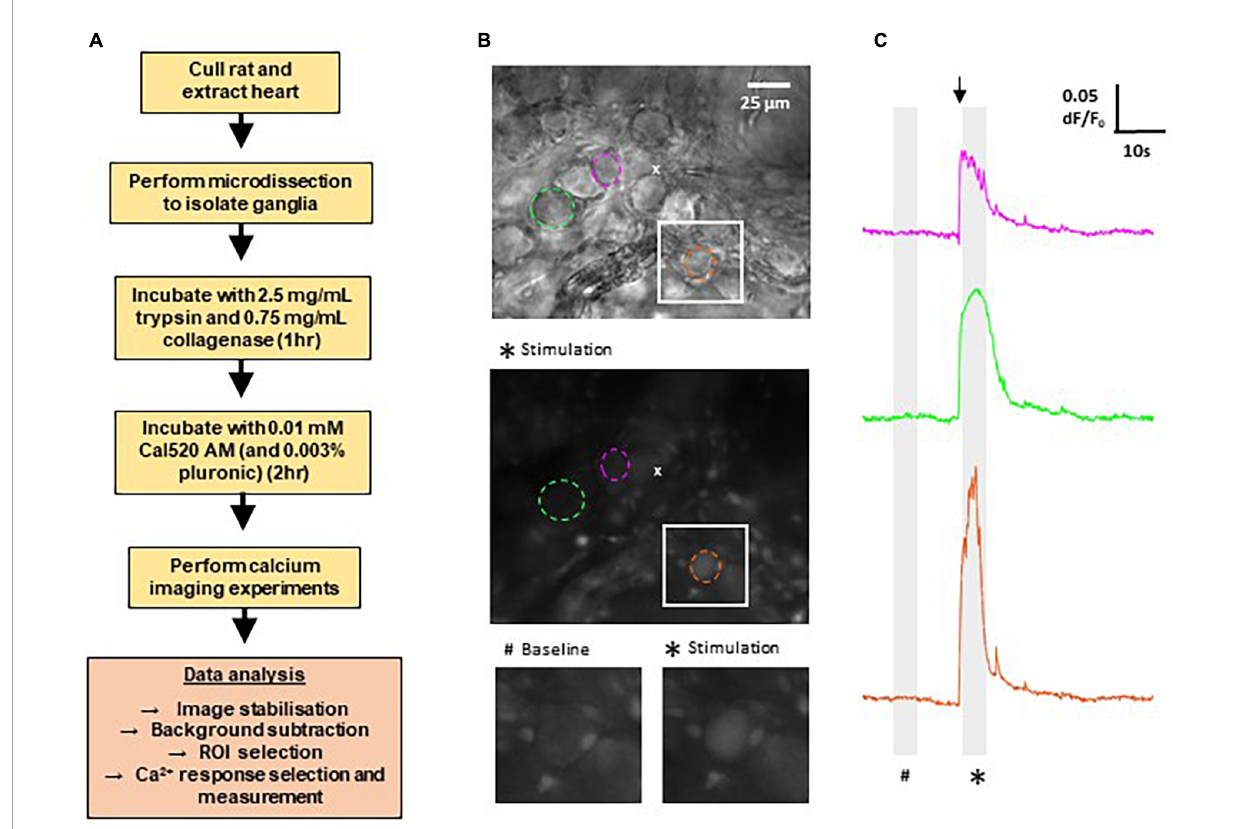
FIGURE1 Methods for calcium imaging in rat ganglionated plexi (GP) neurons. (A) Flow chart outlining the major steps involved in recording Ca 2 + responses from GP neurons in rat GP. (B) Top: differential interference contrast image of a WKY GP. The location of the micropipette used for acetylthiocholine (ATCh) application is indicated by (x). Middle: fluorescence image of the same region as above, labeled with Cal520 AM. Image shows a maximum intensity projection of 50 frames (5 s) during ATCh stimulation as indicated on the traces ( ∗ ). Example regions of interest (ROIs) are selected around GP neuron soma (dashed circles). Colors correlate to corresponding Ca 2 + traces for each neuron in the right hand side column. Bottom: magnification of the white boxed area in the upper and middle images, highlighting a strongly responding neuron (orange). (C) Example traces of changes in Cal520 AM fluorescence measured in the ROIs in part (B) in response to ATCh stimulation (500 µ M for 200 ms; black arrow). Traces show the baseline fluorescence (#, left) and the increase in fluorescence during ATCh stimulation ( ∗ ,